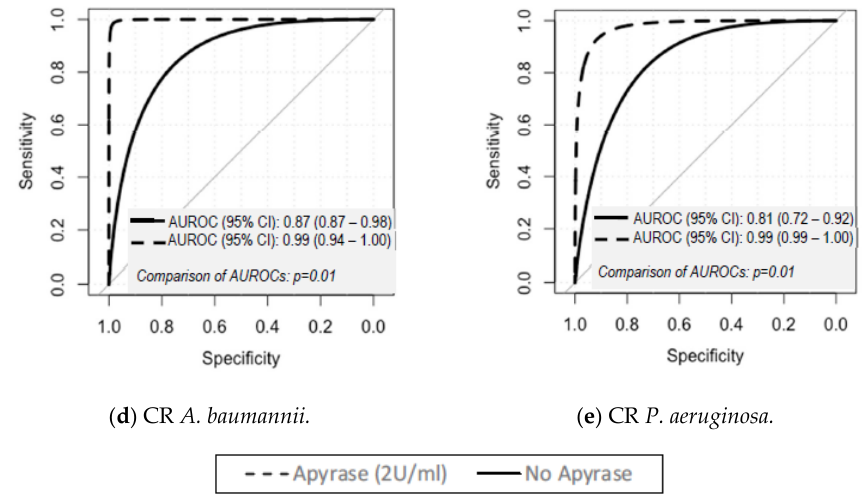
Figure 2. Receiver operating curves ( ROC) plots for distinguishing between inhibitory and non- inhibitory activity at different timepoints for ( a ) All CR-GNB, ( b ) CR E. coli , ( c ) CR Klebsiella spp., ( d ) CR A. baumannii , and ( e ) CR P. aeruginosa with and without apyrase (2 U/mL) in 24 h time–kill studies